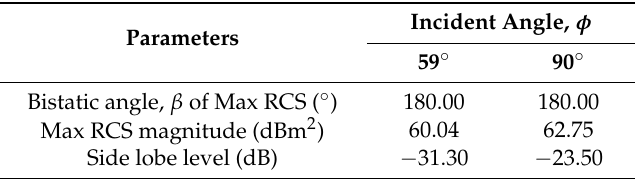
Table 1. Small SUV RCS values for different incident angles, φ .